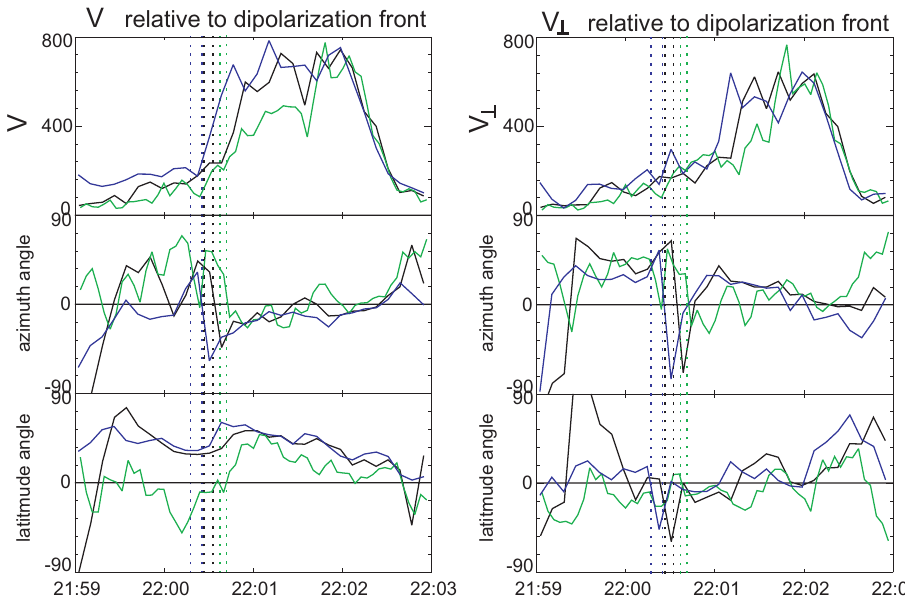
Fig. 6. Clusters 1, 3, and 4 observations of the ion flow speed and direction of the flow relative to the normal direction of the dipolarization front in the X − Y plane and in the X − Z plane. Here the relative azimuth angle corresponds to the angle between the flow and the normal direction in the X − Y plane, whereas the relative latitude angle corresponds in the X − Z plane. The left panels are for the total ion flow, whereas the right panels for the perpendicular component of the flows. The vertical dashed lines show the period of the dipolarization for each spacecraft presented with the same color (Clusters 1, 3 and 4 data are indicated with black, green, and blue) as the velocity